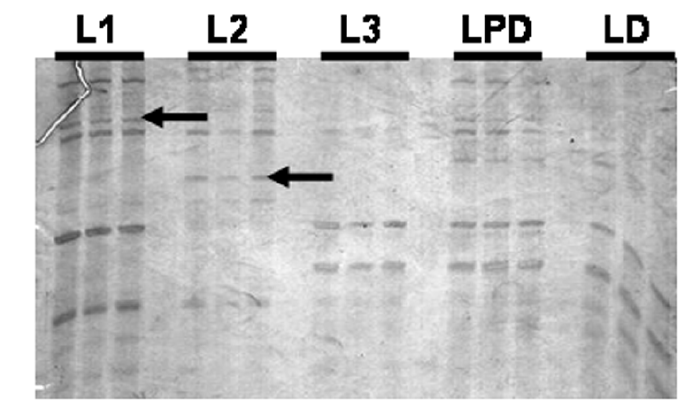
Fig. 1 – Profiles of DDRT-PCR in larval stages of Melipona scutellaris generated using HT11A-AP04 primer combination. 6% denaturing polyacrylamide gel, stained with AgNO 3 . Arrows indicate differentially expressed fragments (performed in trip- licate) in L1 and L2. The in L1 is respected to EST D01 and in L2 to EST B09. Some bands, not stage-specific, with differences of intensity can also be observed during development. Larvae of different stages: larva 1 (L1), larva 2 (L2), larva 3 (L3), predefecating (LPD) and defecating (LD).